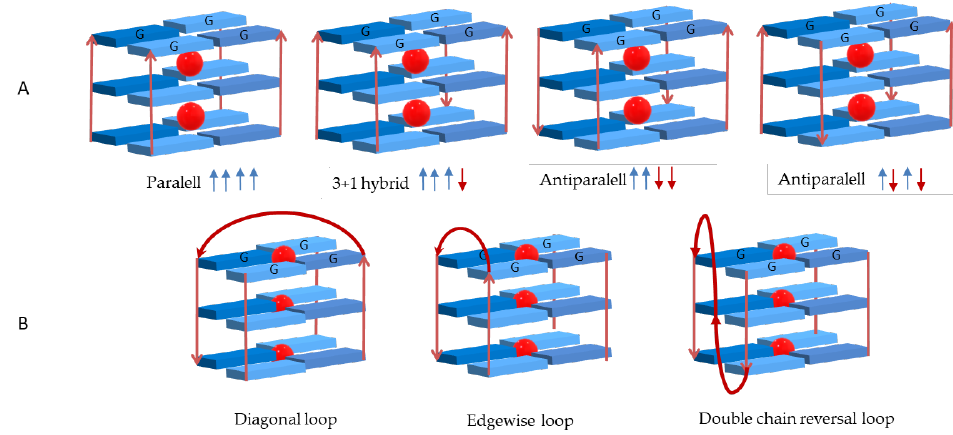
Figure 4. ( A ) Different conformations assumed by G-quadruplexes structures depending on strand orientation and ( B ) possible loop